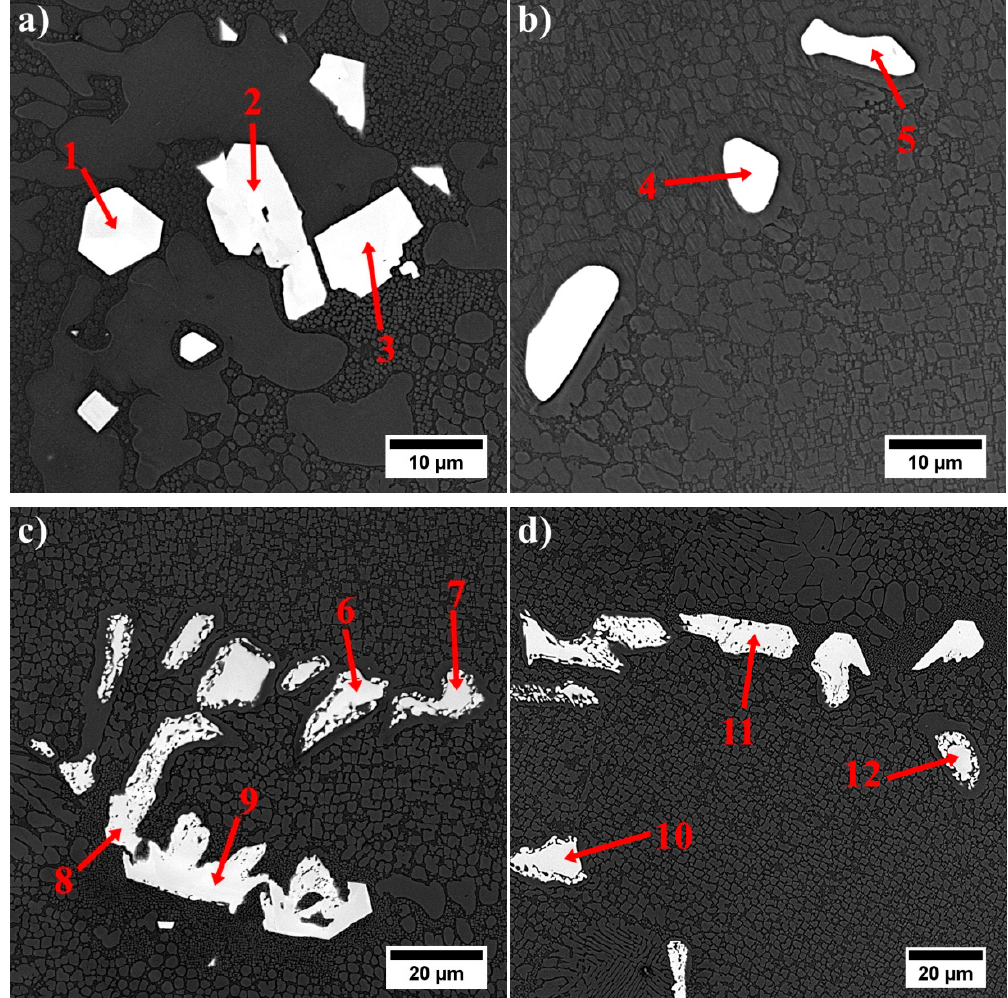
Figure 7. Microstructure of MC carbides and location of SEM-EDX analysis points: ( a ) blocky carbides and points no. 1–3; ( b,c ) carbides surrounded by the coarse γ (cid:48) and points no. 4–9; ( d ) morphologically complex carbides and points no. 10–12. Table 4. Results of SEM-EDX analysis in MC carbides, at%.